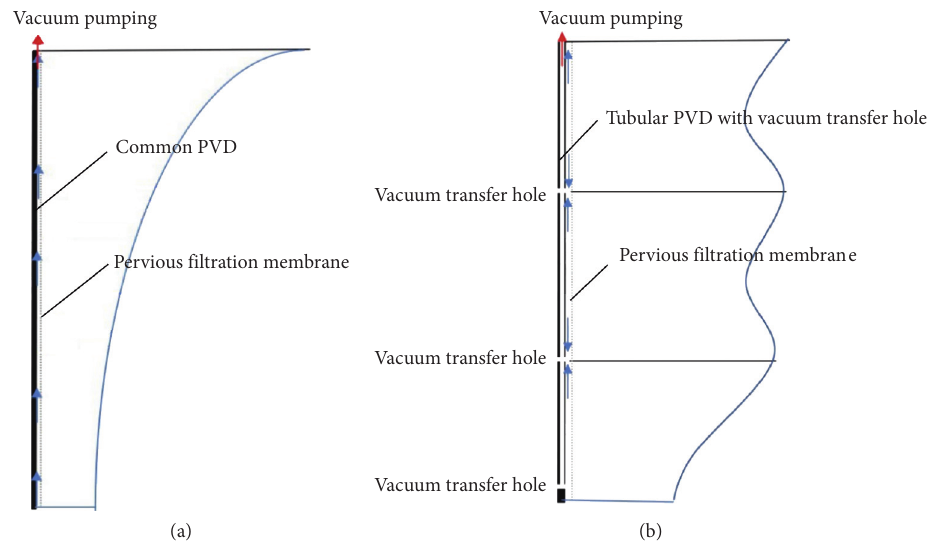
Figure 9: Distribution of the vacuum pressure along PVD: (a) common PVD; (b) new PVD.